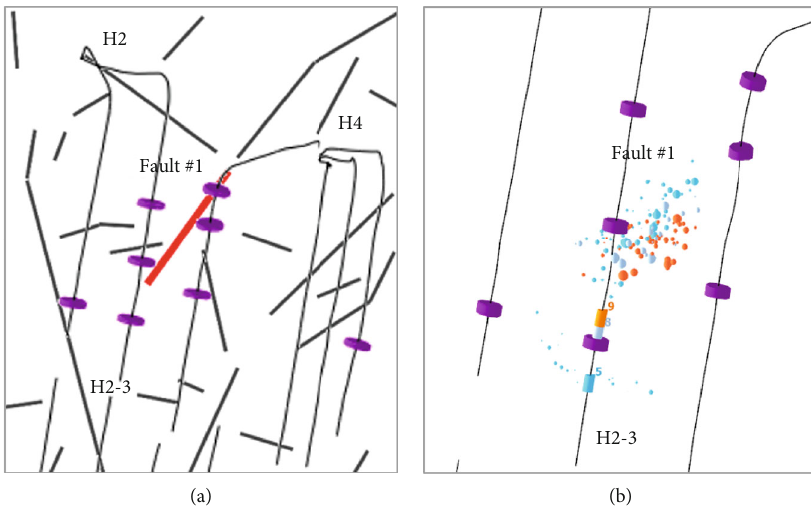
Figure 15: Slip risk validation by microseismic events: (a) the location of Well H2-3; (b) the microseismic events of Well